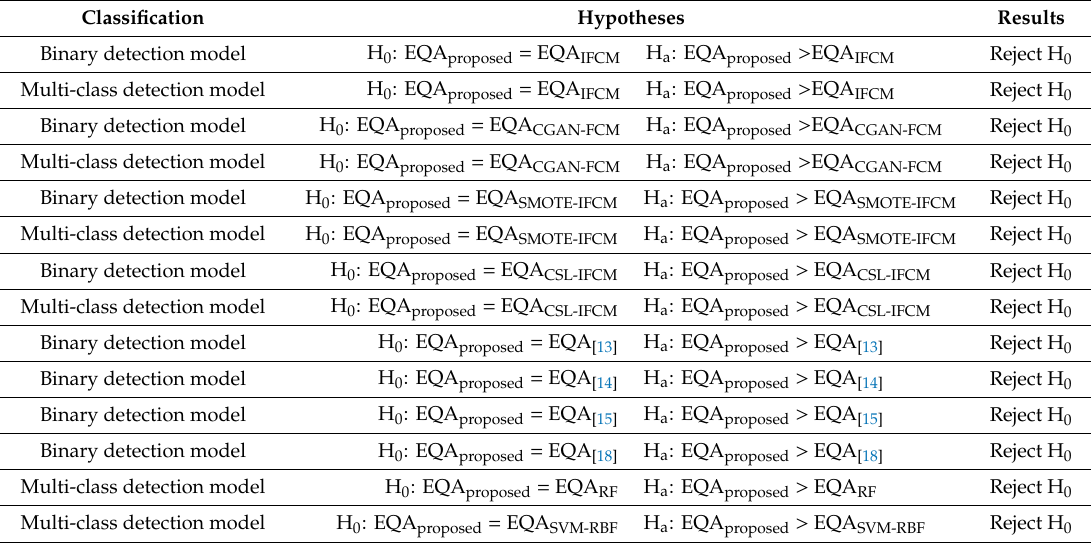
Table 11. Results of Wilcoxon signed-rank test on proposed CGAN-IFCM and various approaches. Classification